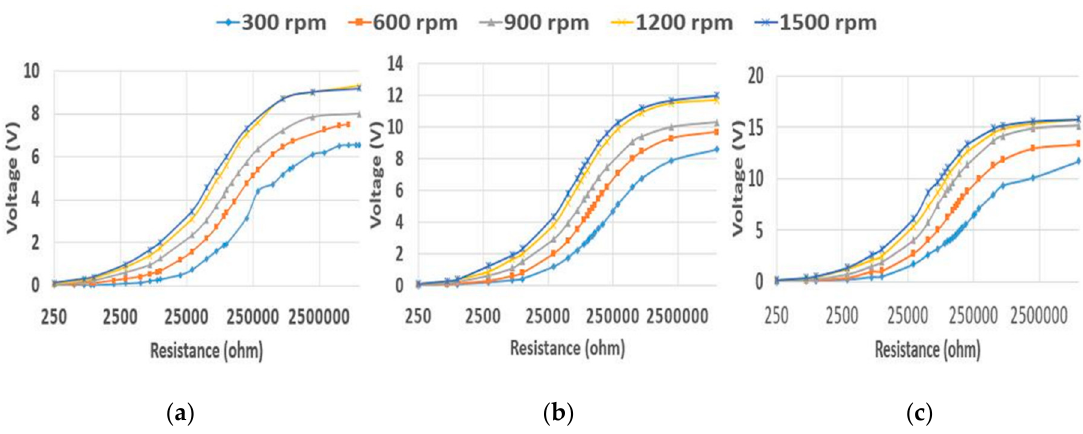
Figure 11. Effect of increasing rotation speed on output voltage using different planet numbers: ( a ) one planet cover, ( b ) two planet covers and ( c ) four planet covers.